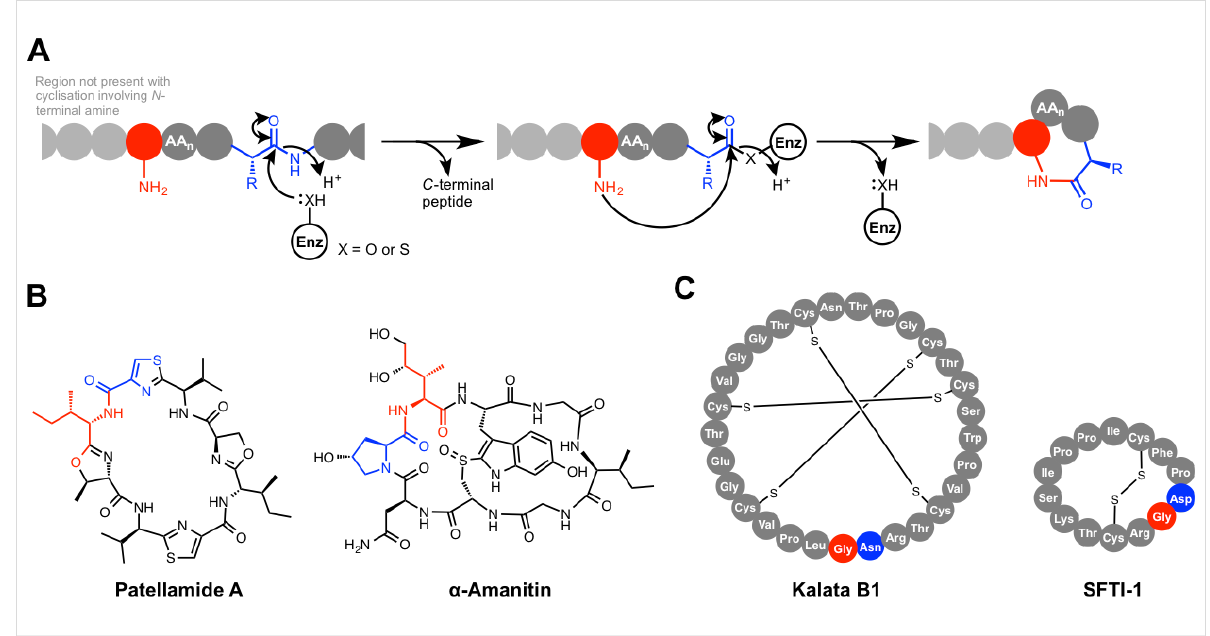
Figure 8: Peptidase-like macrolactam formation. A) General mechanism. B) Examples of RiPPs cyclised by serine protease-like enzymes. C) Examples of RiPPs cyclised by cysteine protease-like enzymes.